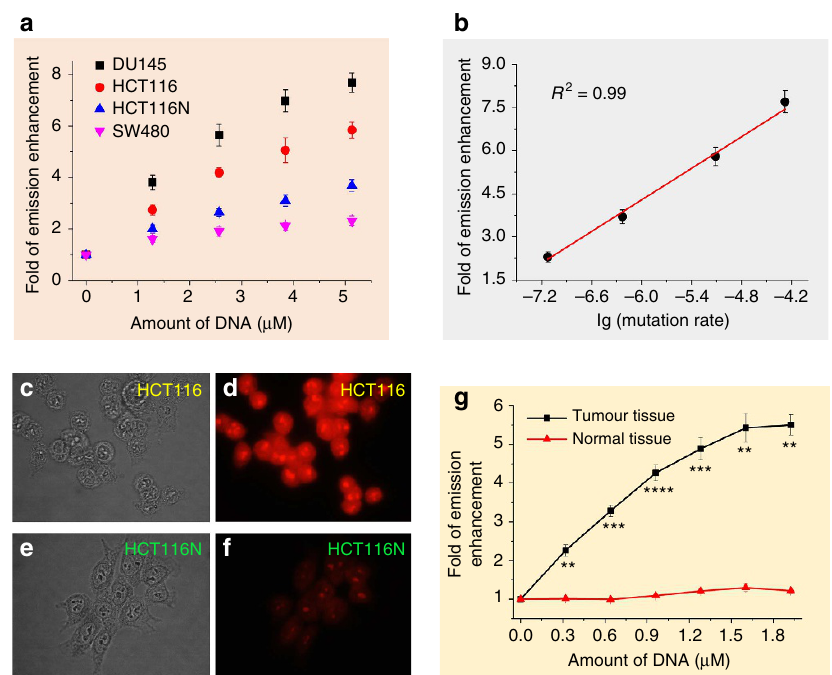
Figure 6 | Detection of mismatched DNA in cancer cells. ( a ) Changes in emission intensity ( ± s.e.m.) of 2 (5 m M) at 634nm in an aqueous buffer solution (50mM NaCl and 2mM Tris, pH 7.5) after binding to genomic DNA extracted from different cancer cell lines. ( b ) Plot of fold of increased emission versus reported mutation rates in different cancer cell lines, lg (mutation rate); a linear fit is shown. Fluorescence microscopy studies of HCT116 ( d ) and HCT116N ( f ) cells pretreated with digitonin and stained with 10 m M 2 ; ( c , e ) bright-field images of HCT116 and HCT116N cells, respectively. ( g ) Plot of emission responses (fold of increase in emission ± s.e.m.) of 2 versus different concentrations of DNA extracted from colon tumour tissue or adjacent normal tissue. All the concentrations of genomic DNA are shown as base pair